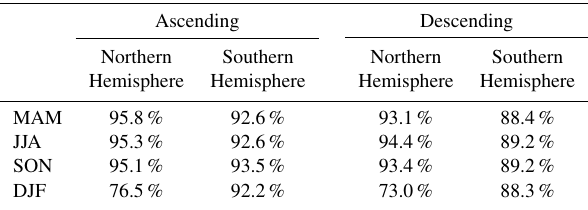
Table 6. The percentages of land areas having high QC retrievals summarized by seasons and sensor orbits; seasons aggregated by spring (MAM), summer (JJA), autumn (SON), and winter (DJF) months of the Northern Hemisphere.